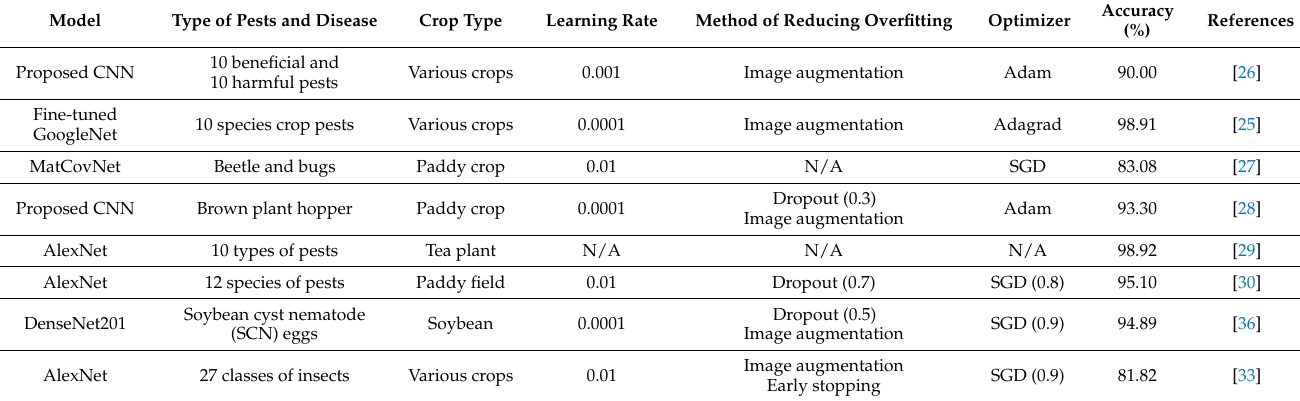
Table 1. Summary of existing pest detection models using deep learning